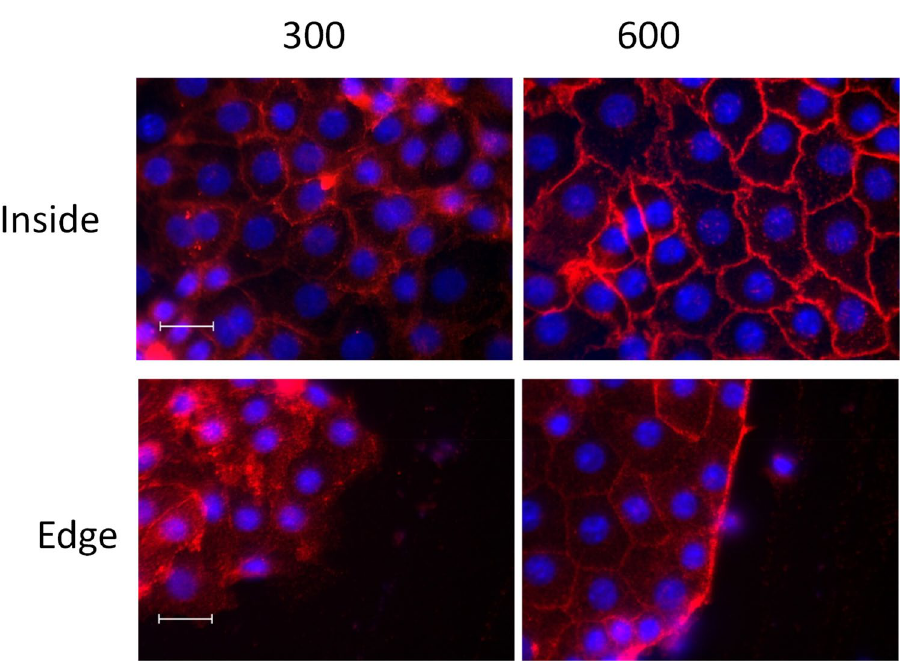
Figure 5. Localization of NHE1 in migrating IMCD-cells at different osmolality. IMCD-cells were cultured at 300- and 600 mosmol/kg. A scratch was induced and the cells were further cultivated for four hours. After that the cells were incubated with NHE1- antibody and Alexa-594 labeled secondary antibody. Images were taken from the leading edge of migrating cells and from the inside of the cell monolayer. Profile plots are provided as Supplementary Fig. 5. Scale bar, 20